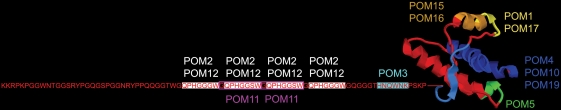
Summary of epitope specificities of POM antibodies.POM2 and 12 bind a degenerative epitope within the octarepeat sequence, whereas POM11 shows stronger binding to a mouse-specific variation of the sequence – QPHGGSW instead of QPHGGG/SW for the other two. POM3 binds a unique sequence near the centre of the PrP molecule (aa 95–100: HNQWNK). The rest of the POMs bind epitopes within the globular domain of PrPC and were only approximately defined.